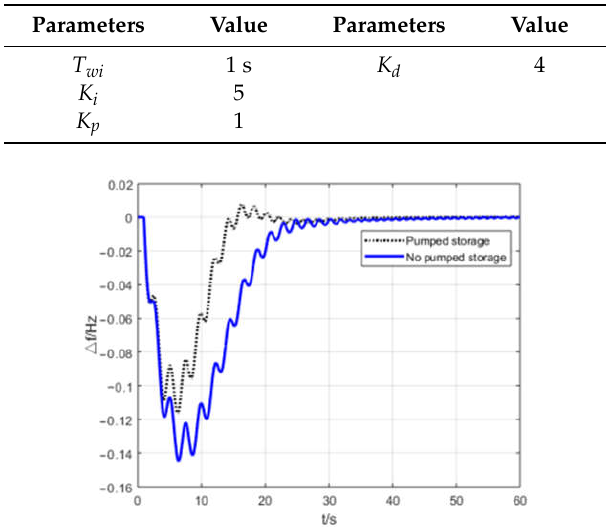
Figure 8. Frequency variation chart of the disturbance zone at generating operation mode.